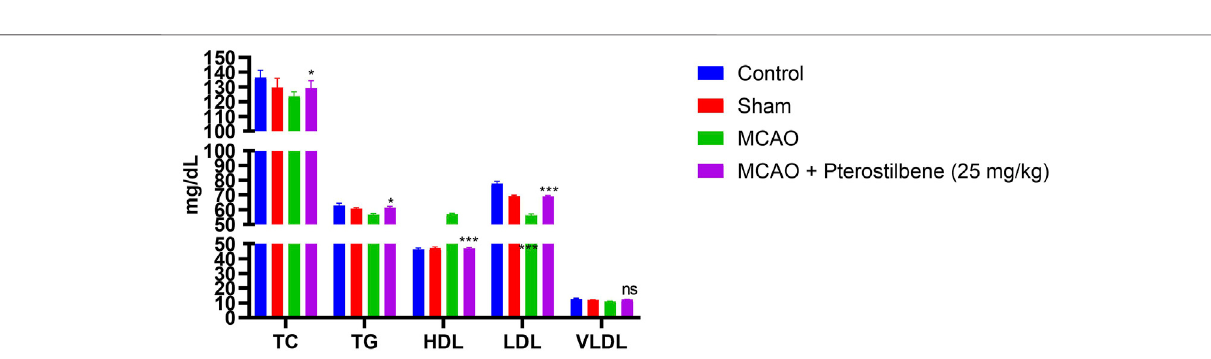
Frontiers in Pharmacology |